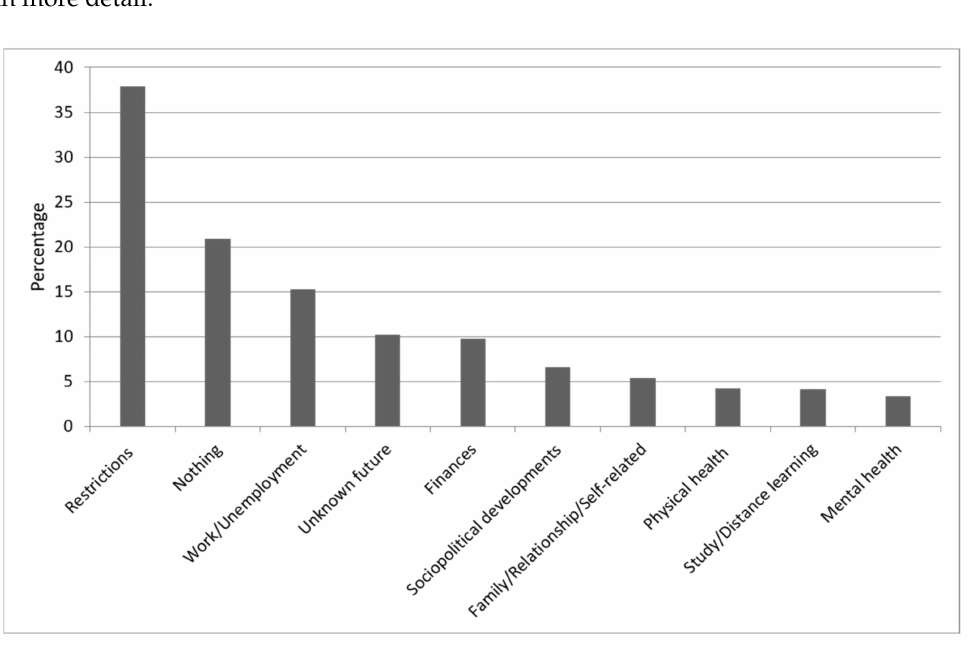
Figure 1. Sources of problems since the beginning of the pandemic. The percentages of participants reporting each main category of problem area that emerged from the data for the first question: “Which problem areas have emerged since the beginning of the